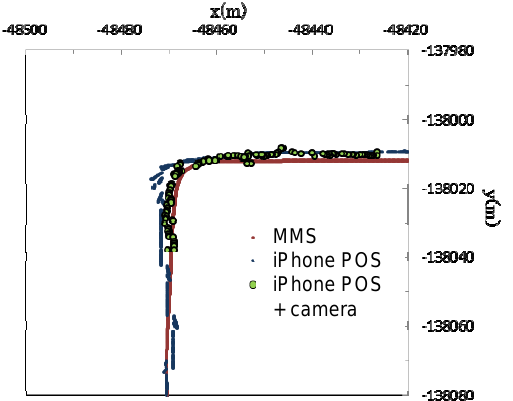
Figure 10. Result of position with all sensors